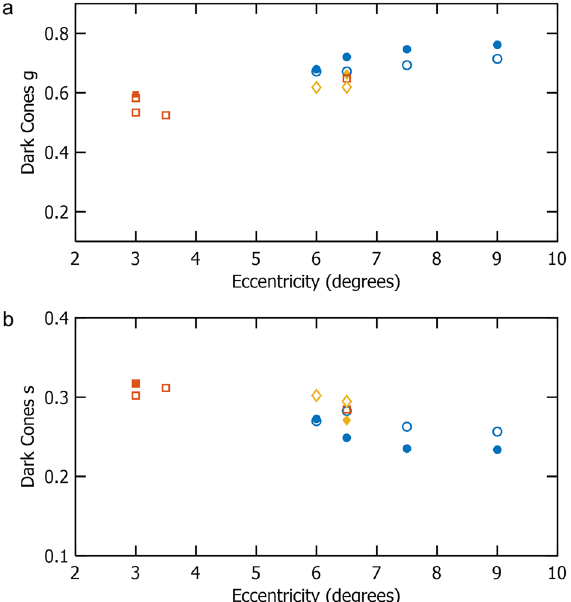
Figure 6. The dependence of the phasor coordinates of damaged cones on eccentricity. Plots of average phasor coordinates g ( a ) and s ( b ) versus eccentricity for images acquired with Paradigm 2 containing multiple cones that decrease in fluorescence intensity. Within each plot, a point represents one of 10 locations in 3 monkeys (blue circles—308; red squares—406; yellow triangles—605). Some cones were already damaged and were subsequently identified in Paradigm 2 first exposure (filled). Other cones were damaged as expected and identified in Paradigm 2 s exposure